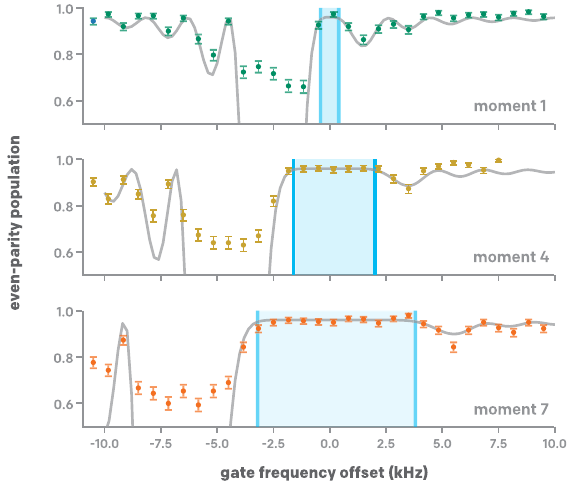
Fig. 5 Experimental demonstration of K -moment stabilized two- qubit gates. A single XX( π /2) gate is applied to the fi ducial state 00 j i , and the even-parity population is plotted as a function of the gate frequency offset. For increasing moment stabilization (shown are K = 1, 4, 7), the region of high even-parity population increases, as indicated by the detuning-robust region shaded in blue. The gray line shows the analytical expression [Supplementary Eq. (60)], valid in the low-error limit, with a 4% offset to account for other sources of in fi delity that are independent of the gate frequency. Notice that our experiment reproduces the oscillating fi ne structure of the fi delity expression, Supplementary Eq. (60). Error bars on the experimental data are 1 σ con fi dence intervals, sampled from a binomial distribution, and each point represents 300 realizations of the